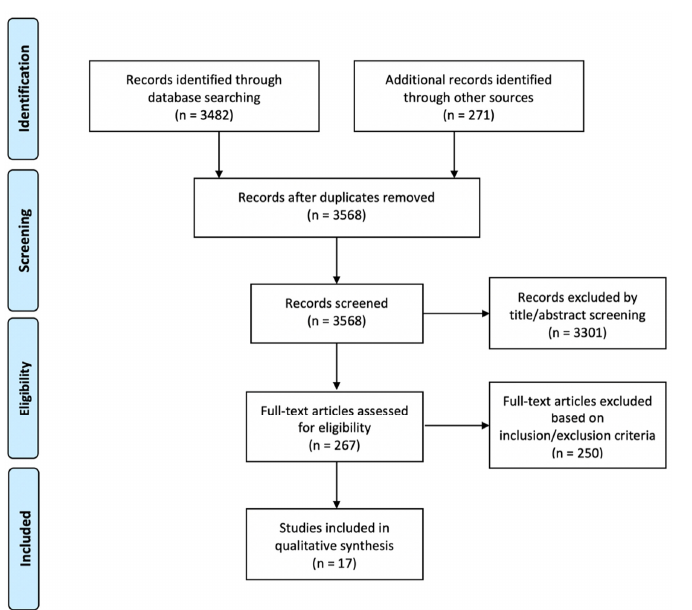
Figure 1. The Preferred Reporting Items for Systematic Reviews and Meta-Analyses (PRISMA) flow chart.